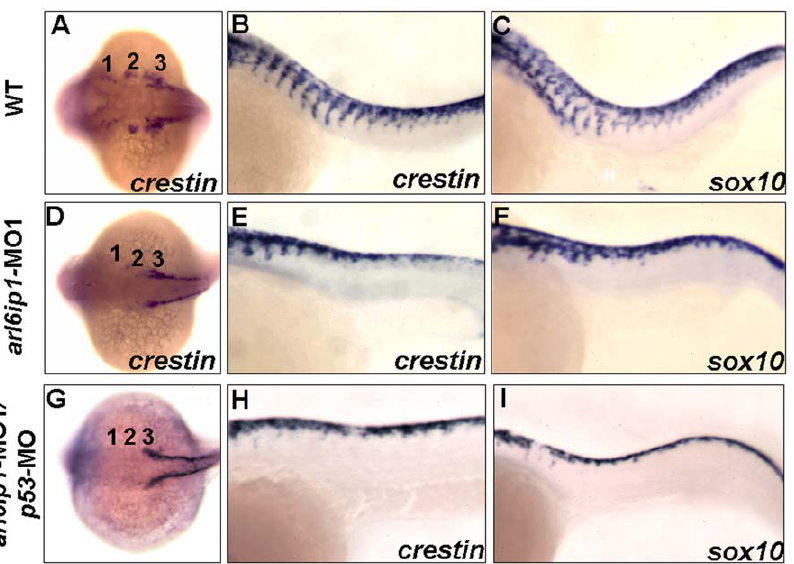
Figure 6. Abnormal cell migration in arl6ip1 -MO1-injected embryos. Wild-type (A–C), arl6ip1- MO1-injected (D–F) and arl6ip1 -MO1/ p53 -MO- injected (G–I) embryos were shown under dorsal views at 20-hpf (A, D, G) and under lateral views at 26-hpf (B, C, E, F, H, I), anterior to the left. Crestin expression revealed the migration of the three cranial neural crest streams in the wild-type embryos at 20 hpf (A). In arl6ip1 and arl6ip1 / p53 knockdown embryos, crestin expression in the cranial crest was reduced in the 3rd neural crest stream and almost absent in the 1st and 2nd stream (D, G). At 26 hpf, the trunk migratory neural crest cells in wild-type embryos, as labeled by crestin and sox10 , gradually migrated to ventral (B, C). However, the sox10- and crestin- expressing cells in arl6ip1 knockdown and arl6ip1 -MO1/ p53 -MO-injected embryos failed to migrate ventrally (E, F, H,